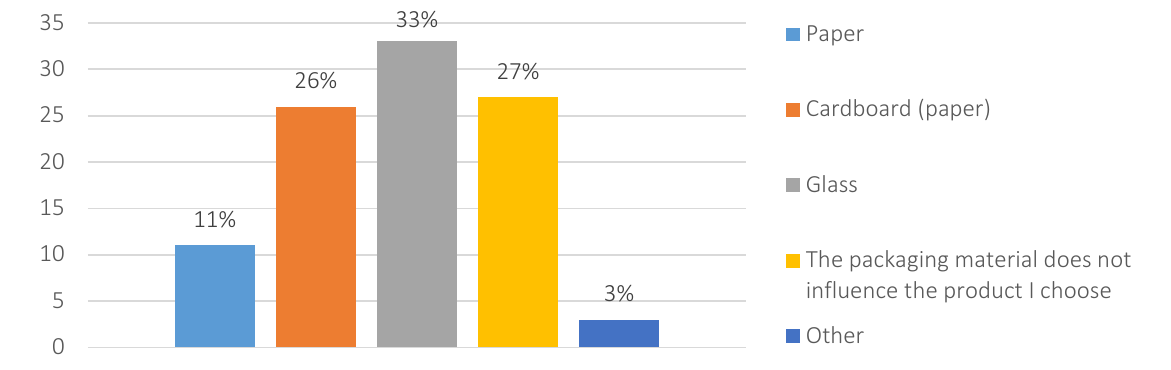
Figure 3. The respondents’ answers to the